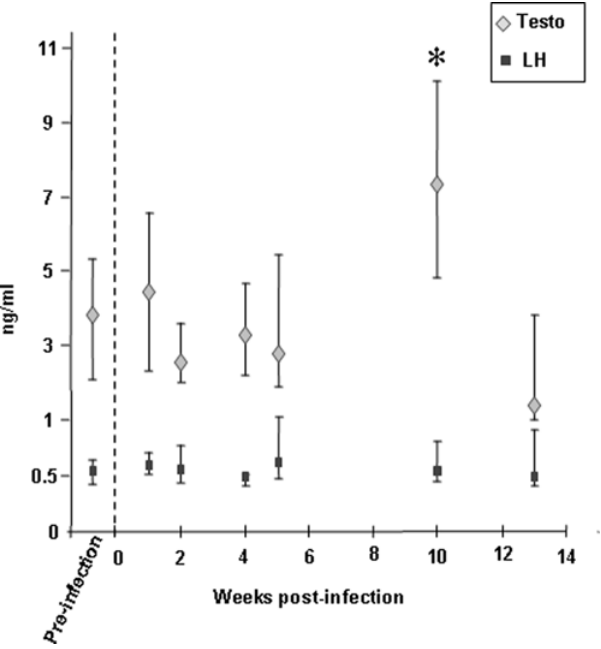
Figure 9. Testosterone and LH levels measured in macaques’ serum. Results are expressed as the median value + / 2 Q3 and Q1 quartiles. Pre-infection testosterone and LH values each represents the pool of three measures performed on twelve macaques at different time points prior to infection. For each time point p.i., 12 animals were tested. * indicates statistical difference to the pre-infection level (Wilcoxon test, p , 0,05).